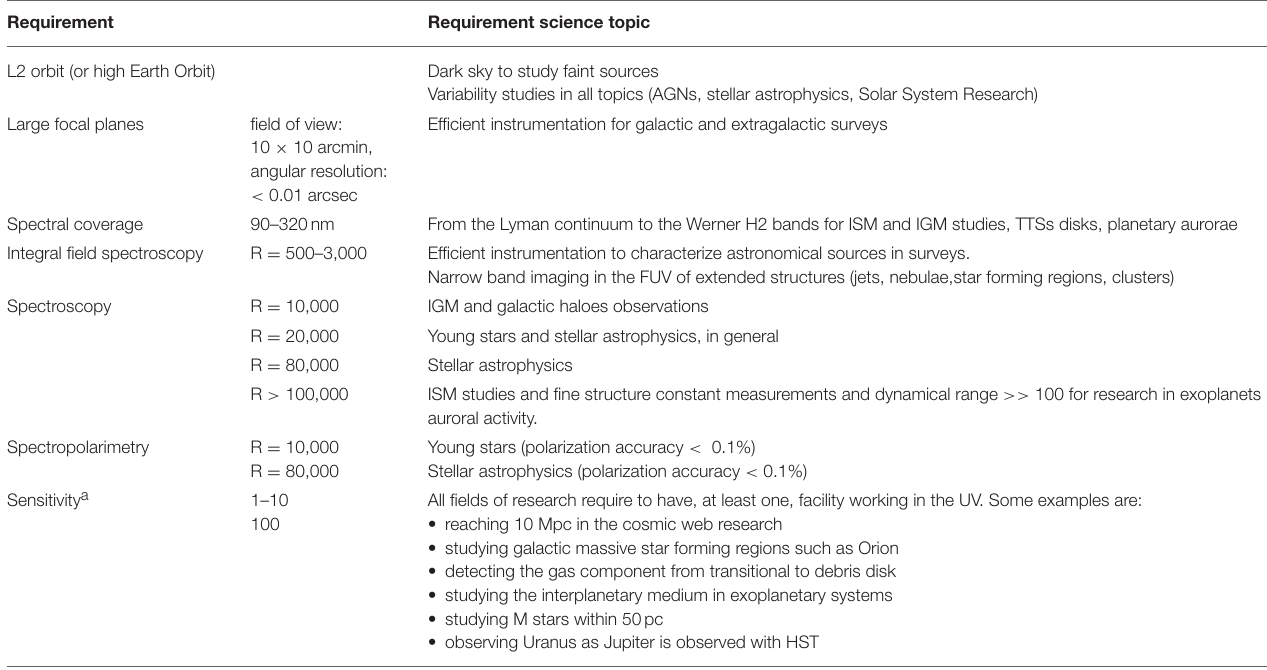
TABLE 1 | Scientific requirements for EUVO from Gómez de Castro et al. (2014).